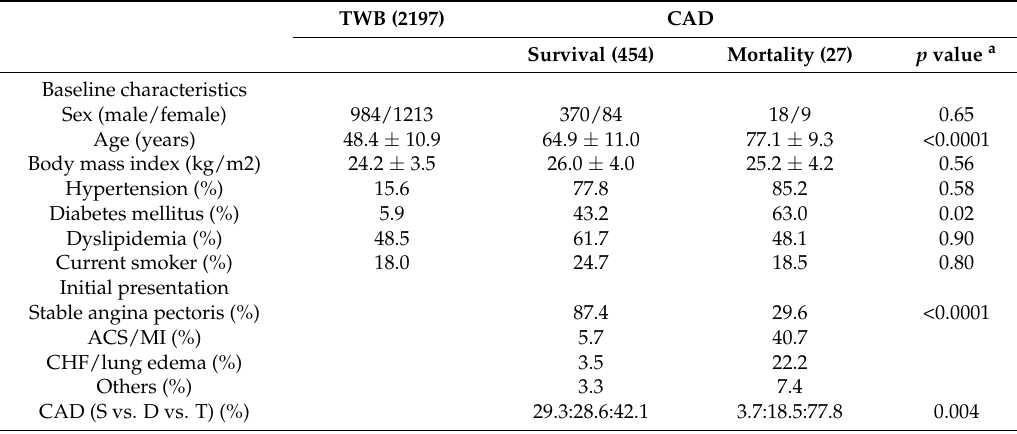
Table 1. Clinical and biochemical characteristics of the Taiwan Biobank (TWB) participants and coronary artery disease (CAD) patients according to their survival